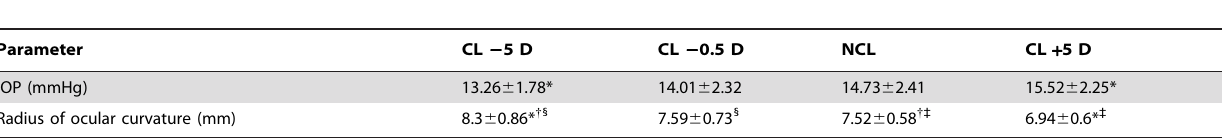
Table 2. Intraocular pressure measured using a non-contact tonometer and the radius of ocular surface curvature obtained with a high-speed